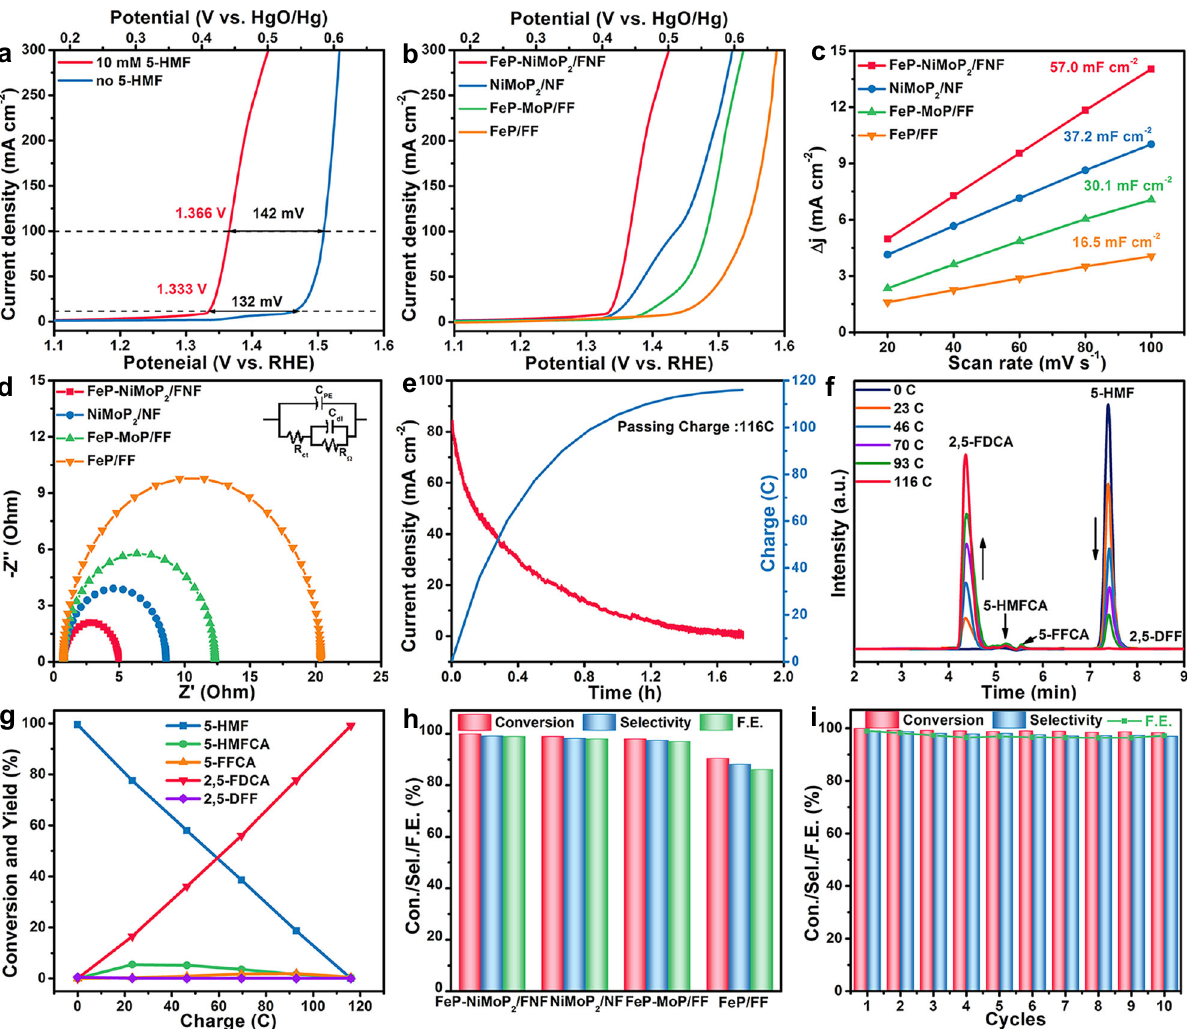
Fig. 4 5-HMF ROR performance. a LSV curves of FeP-NiMoP 2 /FNF in 1.0 M KOH without and with 10 mM 5-HMF at a scan rate of 5 mV s − 1 . b LSV curves, c Capacitive curves, and d Nyquist plots of FeP-NiMoP 2 /FNF, NiMoP 2 /NF, FeP-MoP/FF and FeP/FF. e Chronoamperometric response curve. f HPLC-trace acquired at various charges. g Conversion and yield of reduction products over passed charges. h The conversion, selectivity and FE of 5-HMF EOR for FeP- NiMoP 2 /FNF, NiMoP 2 /NF, FeP-MoP/FF and FeP/FF i Consecutive use of FeP-NiMoP 2 /FNF for ten successive